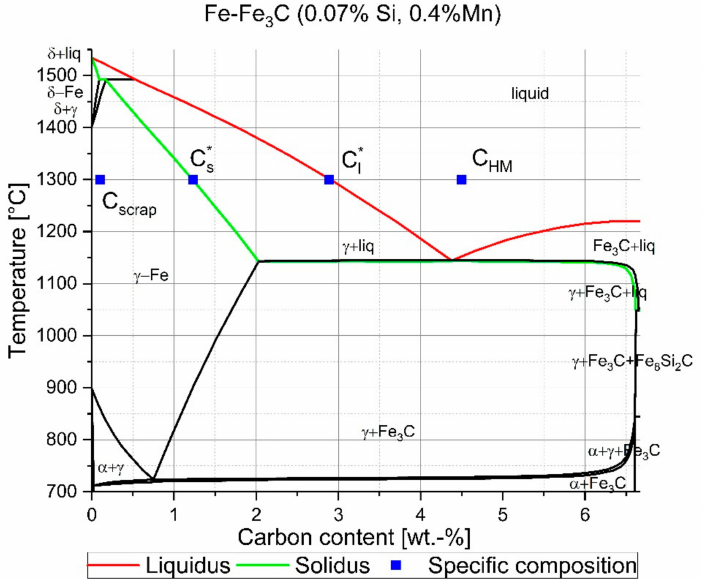
Figure 2. Fe–Fe 3 C phase diagram of common S235JR construction steel scrap including schematic points of carbon